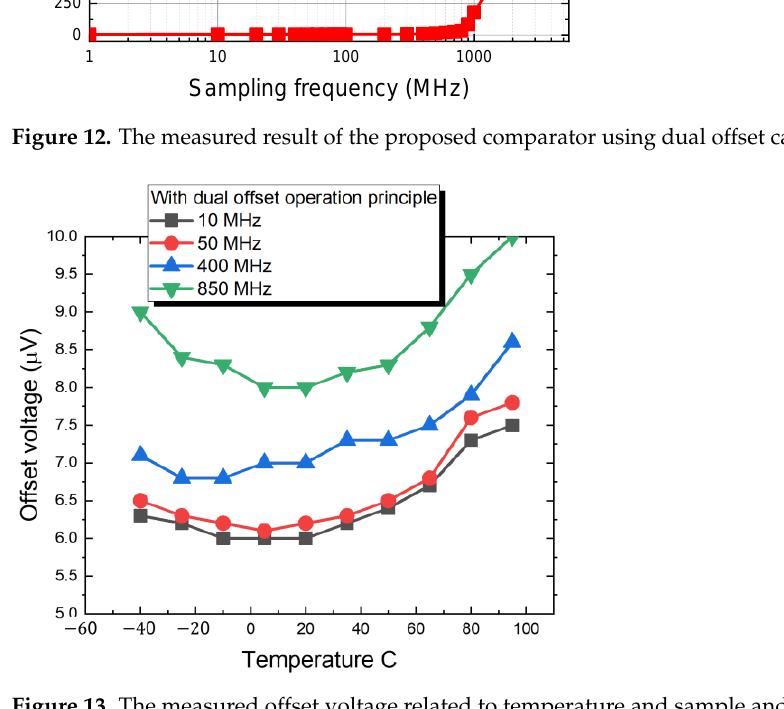
Figure 13. The measured offset voltage related to temperature and sample and hold frequency.